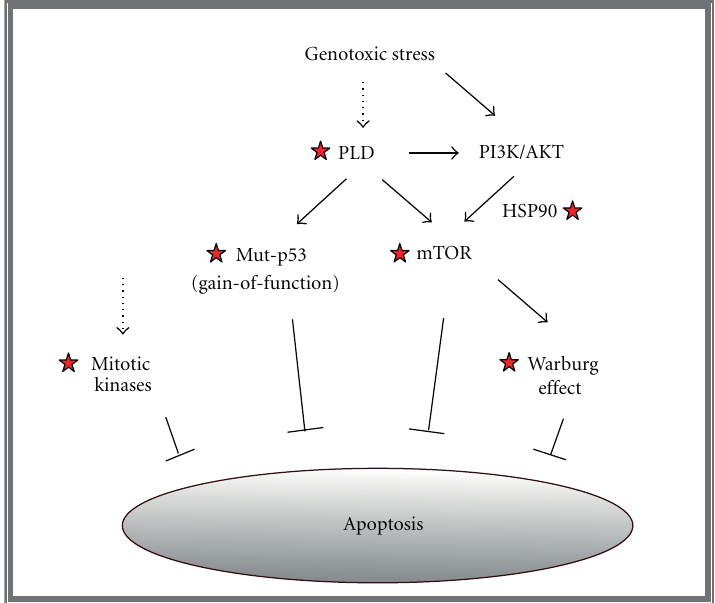
Figure 9: Highly simplified model showing responses triggered by genotoxic stress in human cancer cells. Broken arrows indicate that the mechanism by which cancer-therapeutic agents (e.g., ionizing radiation) might trigger activation of phospholipase D (PLD) and mitotic kinases remain to be determined. However, it is known that PLD contributes to activation of PI3K/AKT signalling [74], and that ionizing radiation triggers mTOR activation through PI3K/AKT [75]. Asterisks mark molecules/pathways that might be targeted, for example, using small-molecule inhibitors, for improving the outcome of cancer radiotherapy (see text for